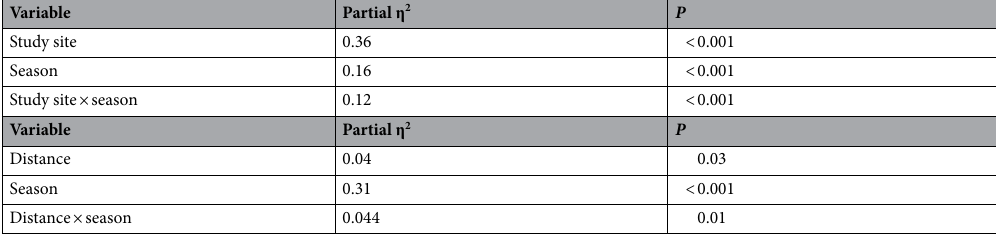
Variable Partial η